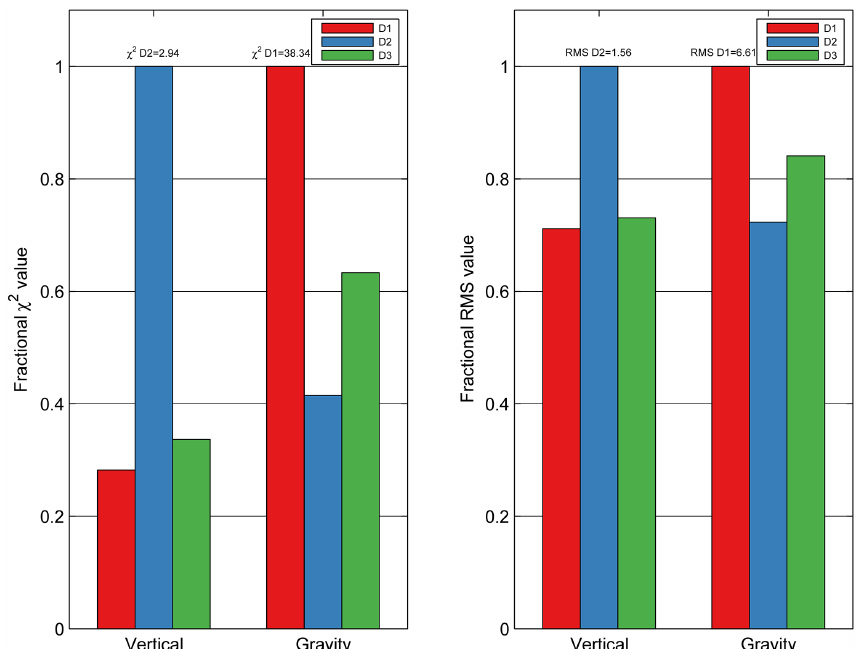
Figure 7. Fractional χ 2 and rms values for each of the D1–D3 models. Fractional values are determined relative to the value of the worst- fitting model for both the vertical motion and gravity change predictions (i.e. fractional χ 2 values of the vertical motion prediction are relative to D2, for which χ 2 = 2 . 94). χ 2 values are not VCE-scaled; see Fig. 8 for all χ 2 values including with and without VCE scaling, where